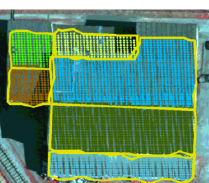
Fig. 9. Yellow lines: Reconstructed outlines of roof planes, other colours show the individual planes.